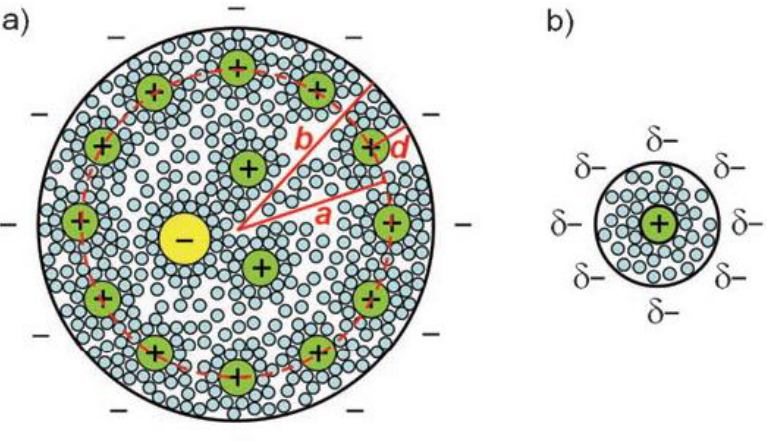
Figure 9. Schematic illustration of a negatively charged mesopore ( a ) and micropore ( b ). The solvated cations migrate towards the wall of the cylindrical mesopore to form the electric double-cylinder capacitor with an outer radius of b and an inner radius of a. In the case of micropore, the solvated cation with a radius of a0 occupies the pore volume and form the electric wire-in-cylinder capacitor. Reproduced from [132], with permission from John Wiley and Sons,